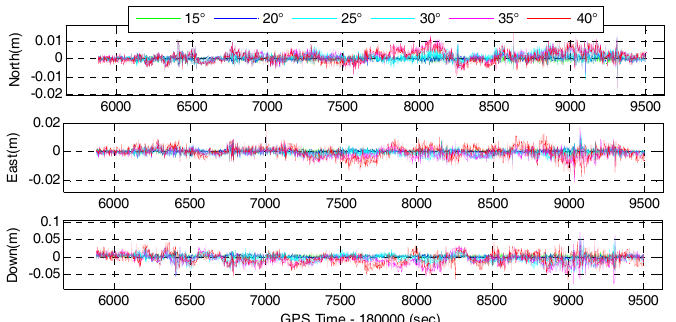
Figure 16. Position difference of GPS/BDS/GLONASS/INS with elevation cut-off angles of 15, 20, 25, 30, 35 and 40°.